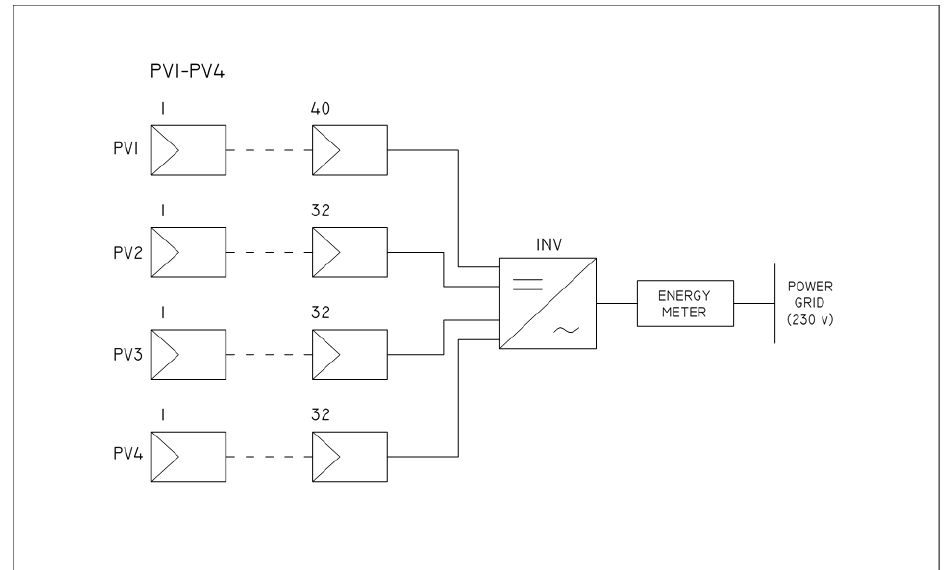
Figure A1. Schematic diagram of PV1–PV4 systems.